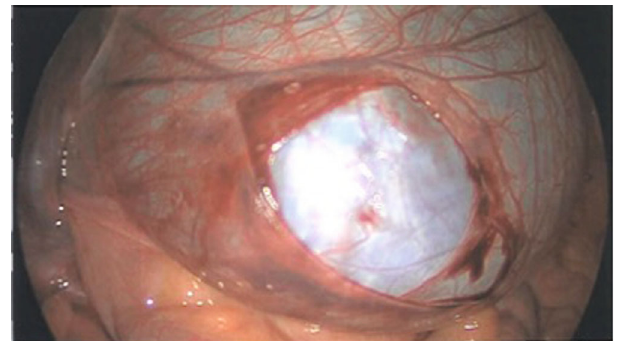
Figure 3: The partially dissected right adnexal cyst.